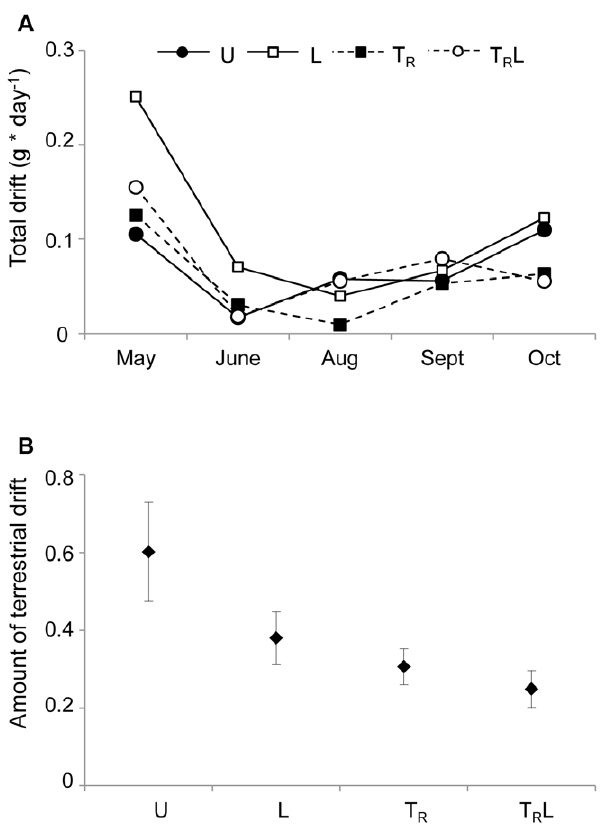
Figure 7. Total and terrestrial drift. Total drift (g/day, mean 6 SE) over the whole season (A) and amount of terrestrial organisms in the drift (biomass based %, seasonal mean 6 SE) (B) in unmanipulated (U), light (L), terrestrial invertebrate reduction (T R ), terrestrial invertebrate reduction 6 light (T R L) treatments.